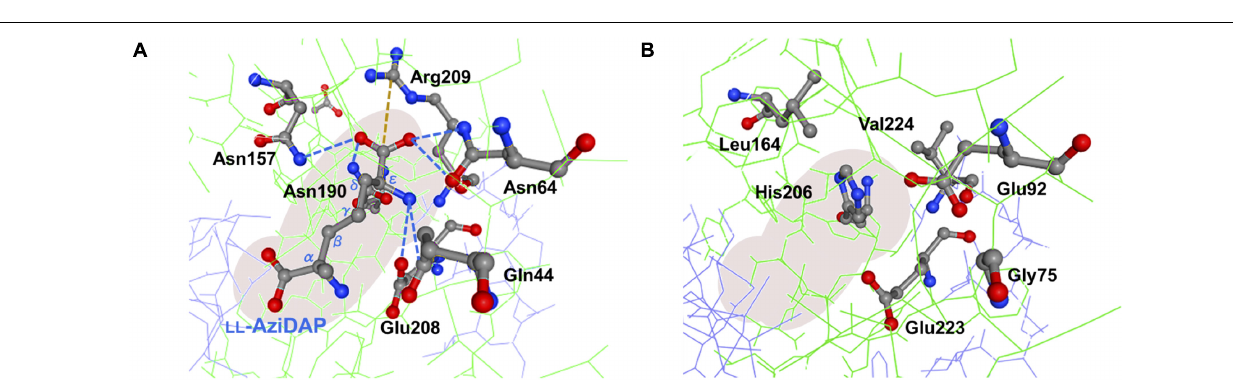
Frontiers in Microbiology |